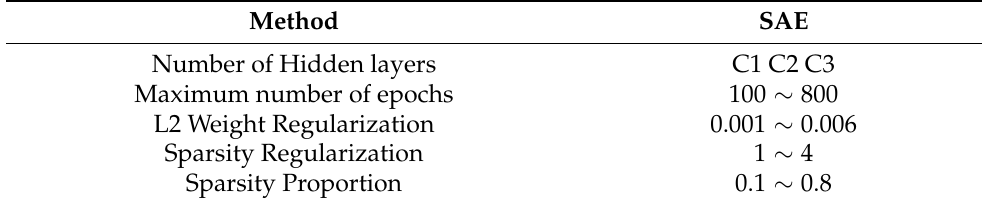
Table 2. Different Stacked Auto Encoder (SAE) architectures used in this